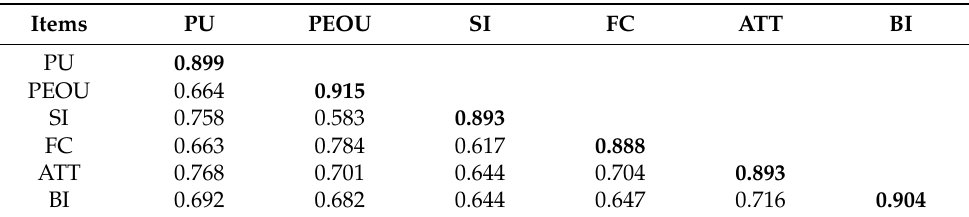
Table 4. Discriminant Validity